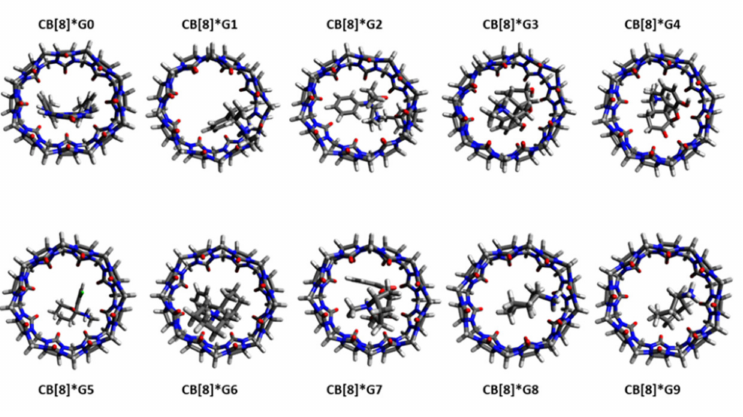
Figure 7. Structures of the top-ranked CB[8]*G0–G9 receptor-ligand complexes. Fentanyl ( G2 ) has a calculated free energy of binding of − 9.84 kcal/mol ( − 11.14